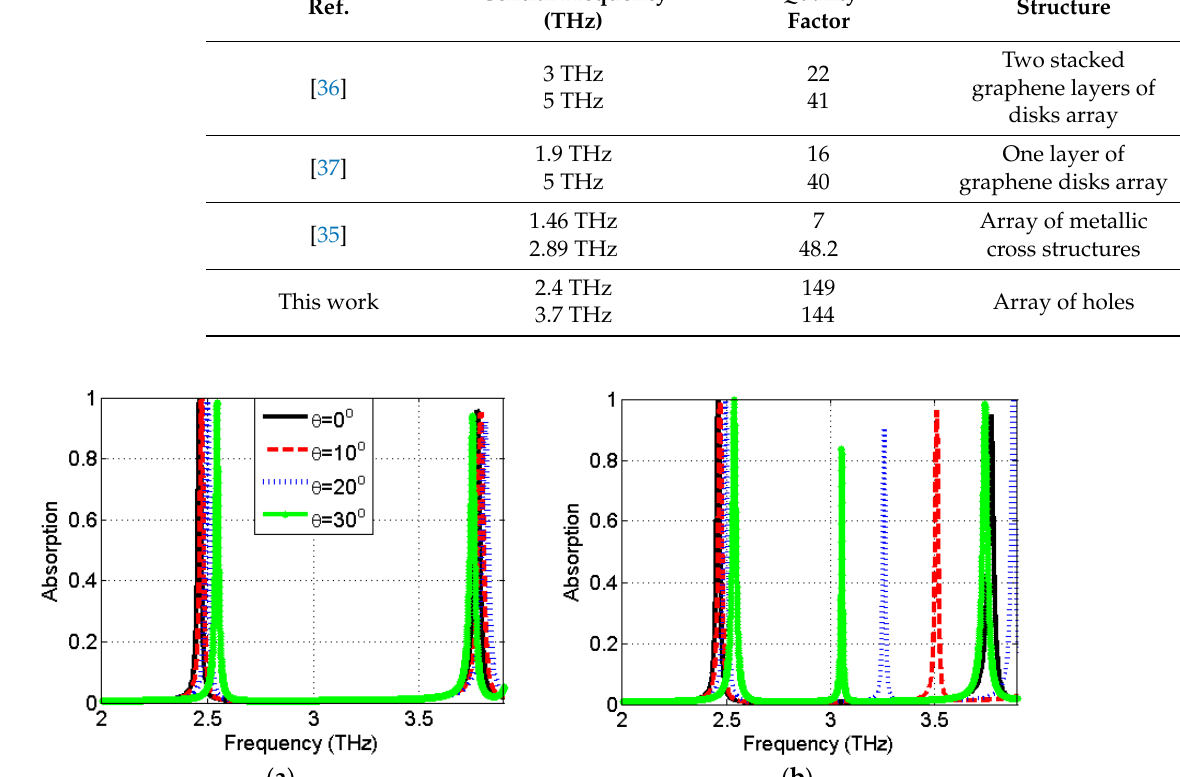
Table 1. Comparison of the proposed narrowband absorber with other reported THz narrowband absorbers.